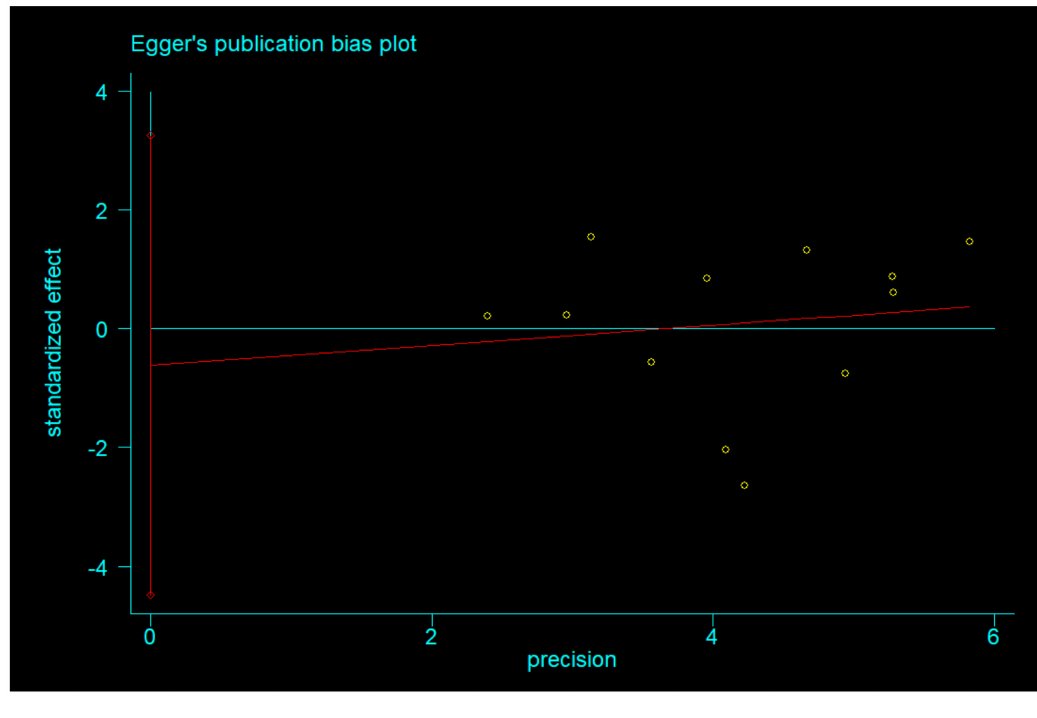
Figure 11. Egger’s publication bias plot of BMI.